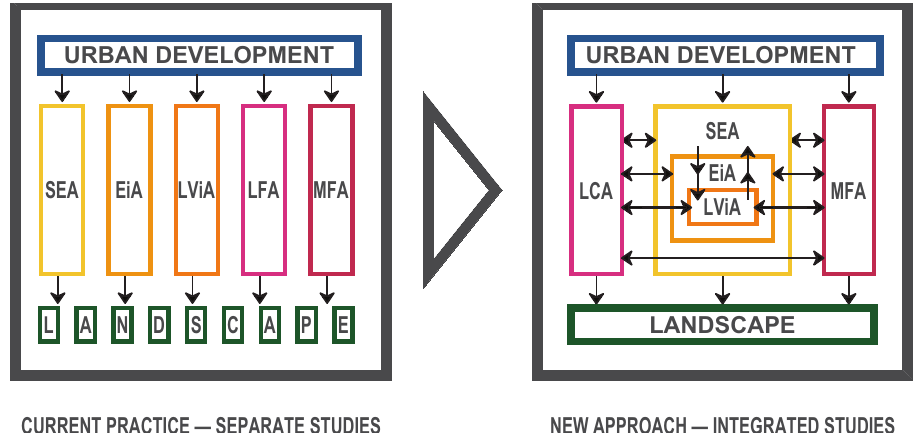
Figure 2. Integration of tools: The recommended holistic approach to landscape